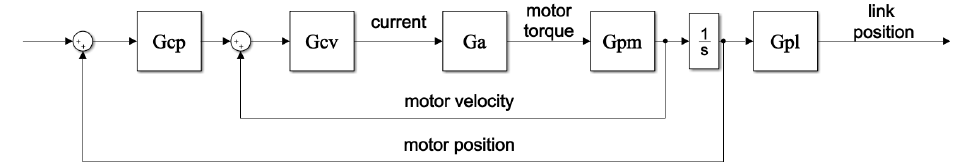
Figure 2. Closed-Loop